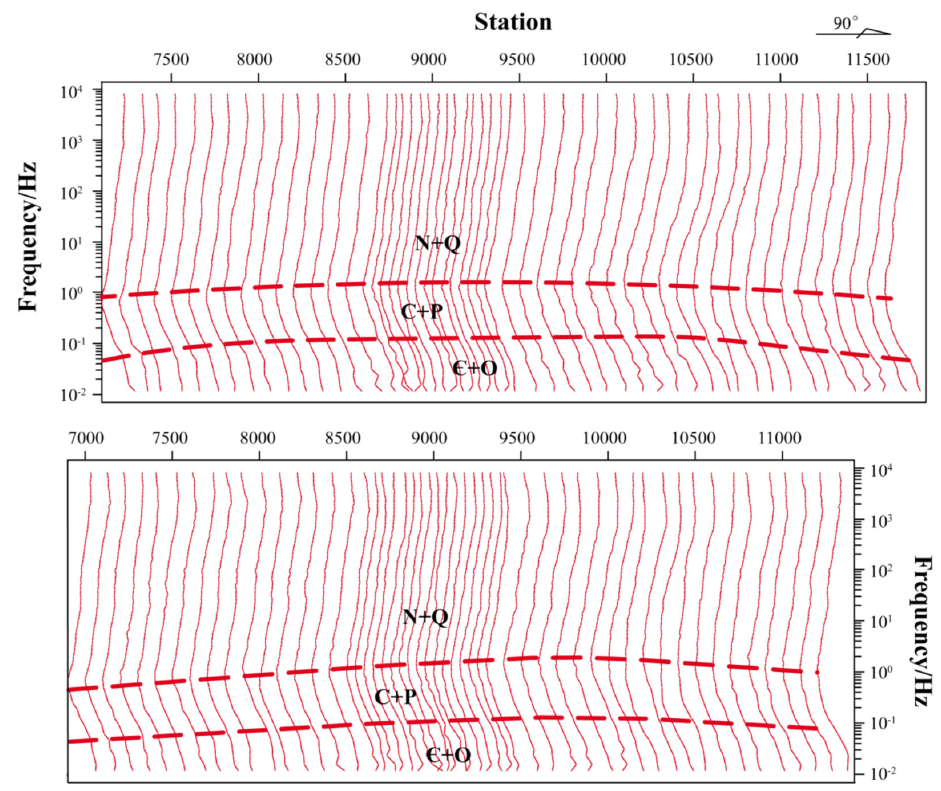
Figure 6. The overall apparent resistivity curves of the Pandian area.